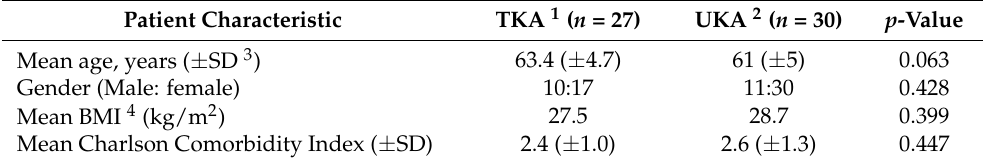
Table 1. Patient Demographics.